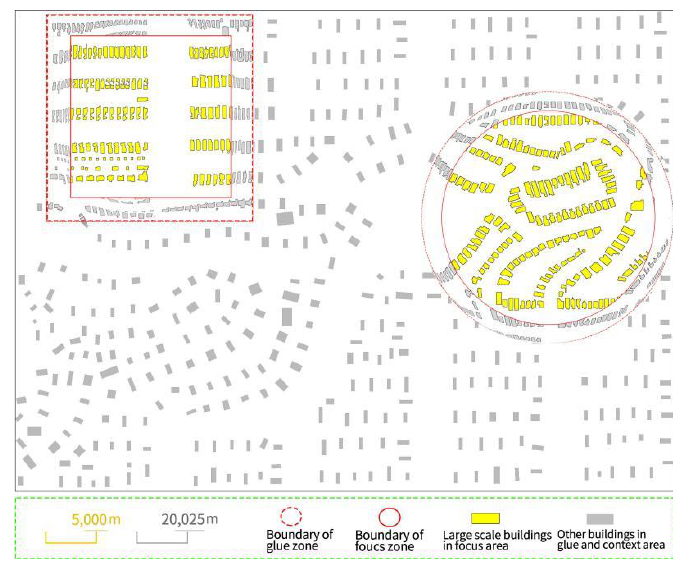
Figure 15. Multicore adaptive variable-scale visualization of buildings.